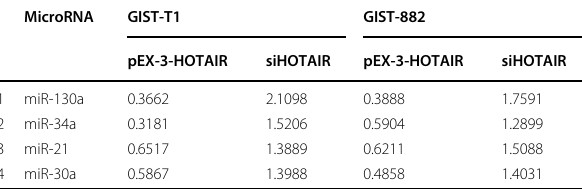
Table 2 Pro fi ling of microRNAs after HOTAIR transfection in gastrointestinal stromal tumors (GIST-T1/GIST-882). MicroRNA